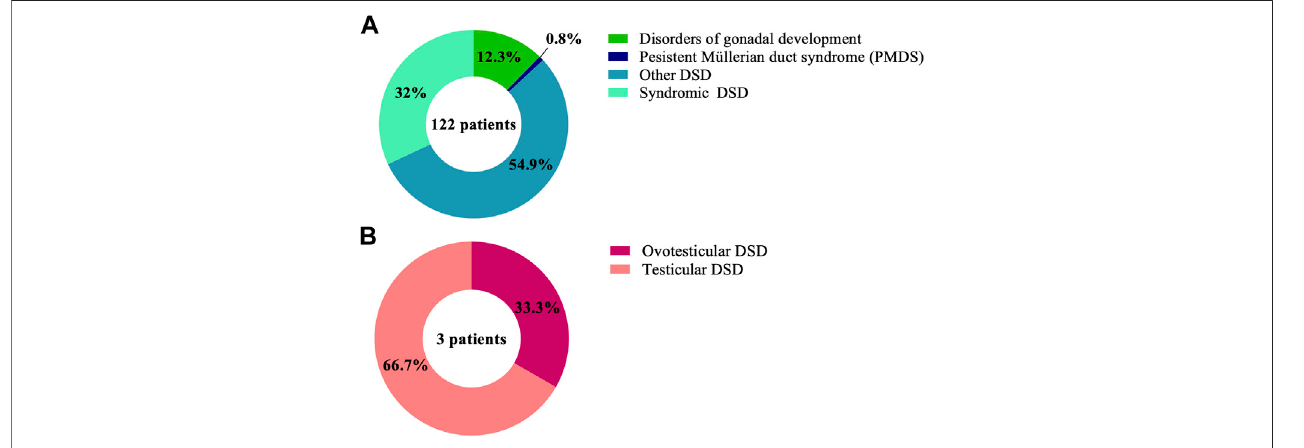
FIGURE 1 | Proportions of the DSD phenotypes in the cohort of 125 patient with (A) 46, XY DSD and (B) 46, XX DSD.